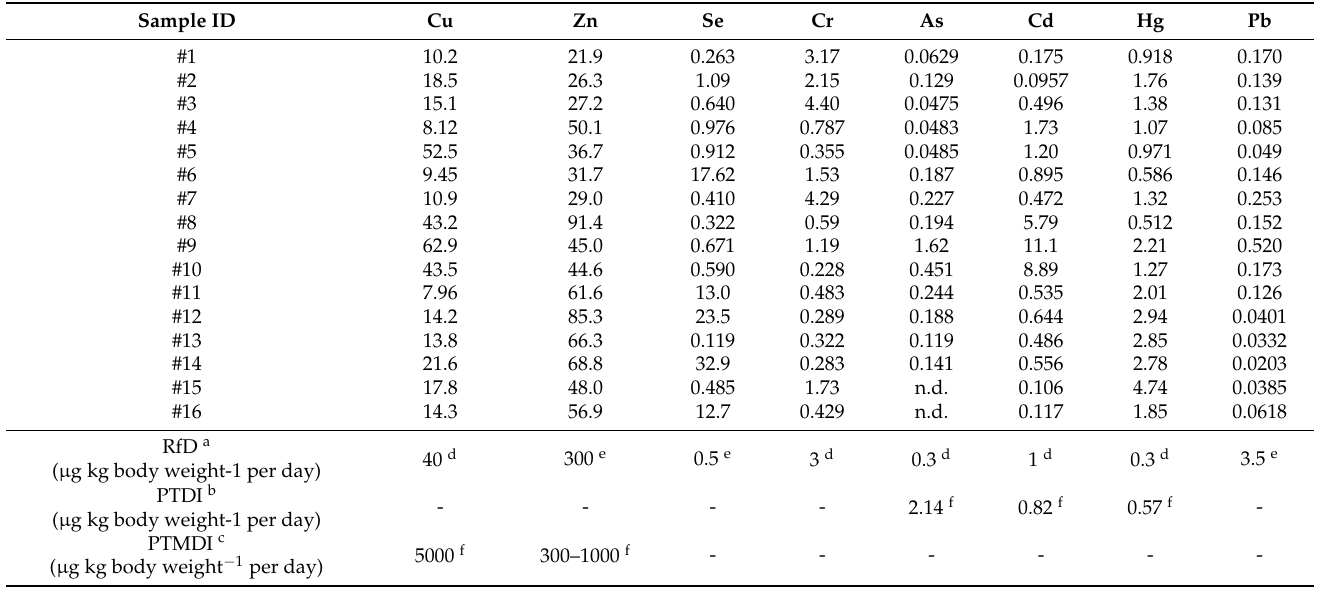
Table 4. Estimated Daily Intake of Metals (EDIM) expressed as µ g kg body weight − 1 per day for the analyzed wild edible mushrooms species from southern Spain and northern Morocco.